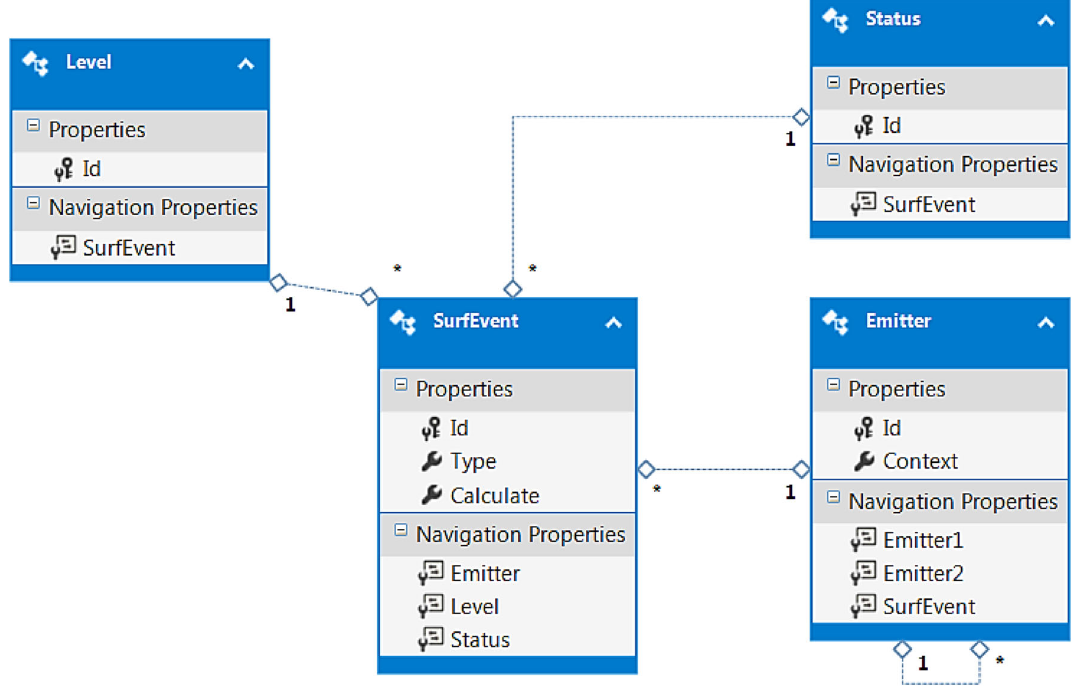
Fig. 7 SurfEvent UML